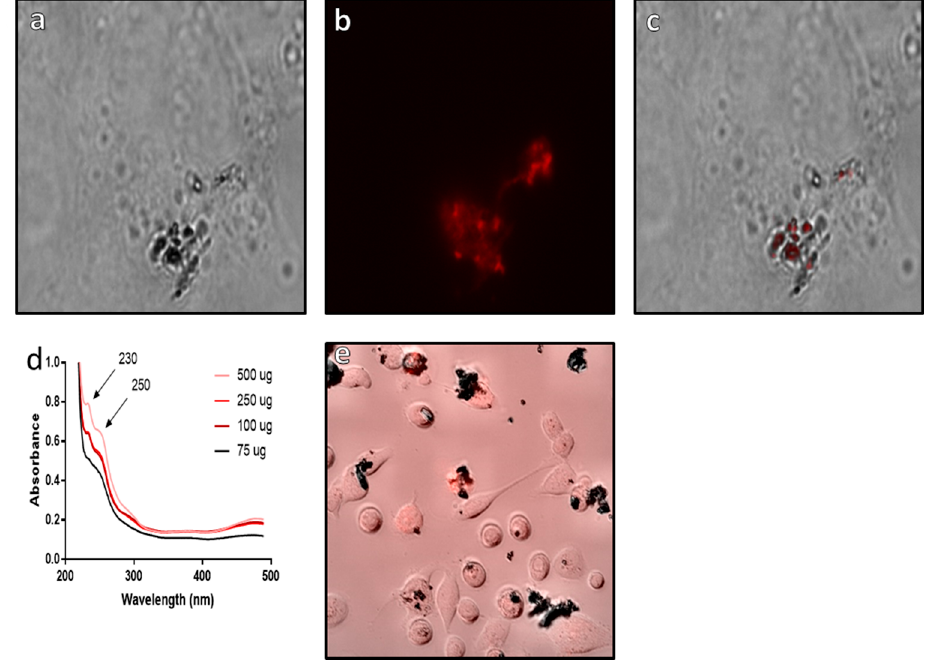
Figure 8. Analysis of epirubicin binding to Si@rMNP. Epirubicin conjugated Si@rMNP under brightfield microscopy ( a ) and fluorescent microscopy ( b ) (images were taken at × 50 magnification), ( c ) a composite image of both bright field and fluorescent channels showing localization of epirubicin to the Si@rMNP, ( d ) UV-vis of Si@rMNP after binding to epirubicin at varying concentrations, ( e ) composite bright field and fluorescent microscopy of epirubicin Si@rMNP uptake with MDA-MB-231 cells.